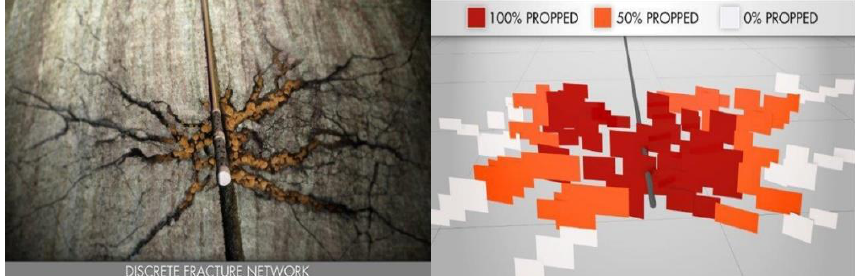
Figure 9. Schematic plot for a propped discrete fracture network.